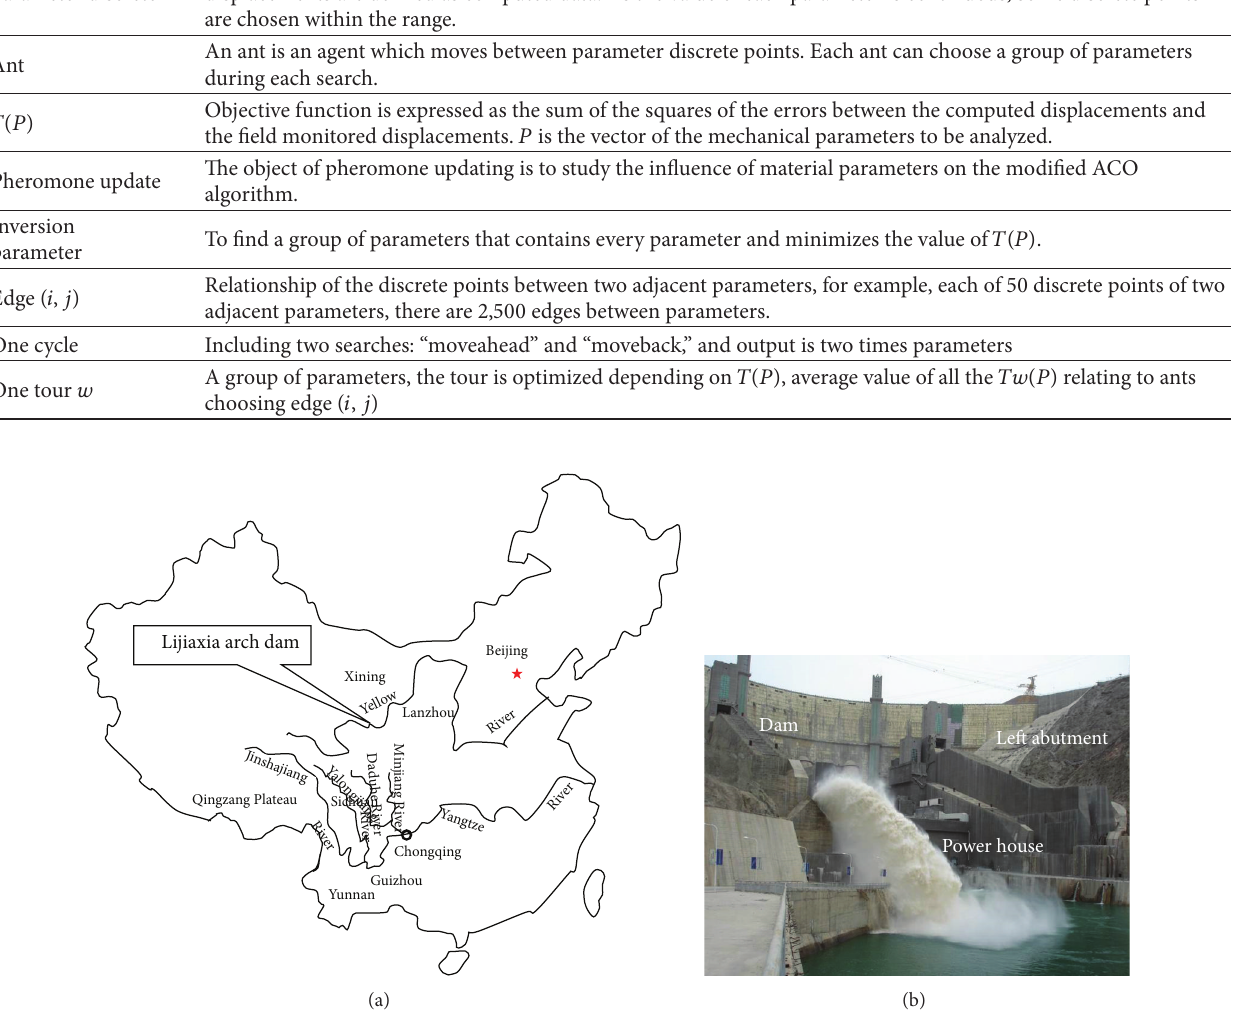
Figure 2: Location map and snapshot of the Lijiaxia arch dam: (a) schematic map of the location; (b) a snapshot of Lijiaxia arch dam.